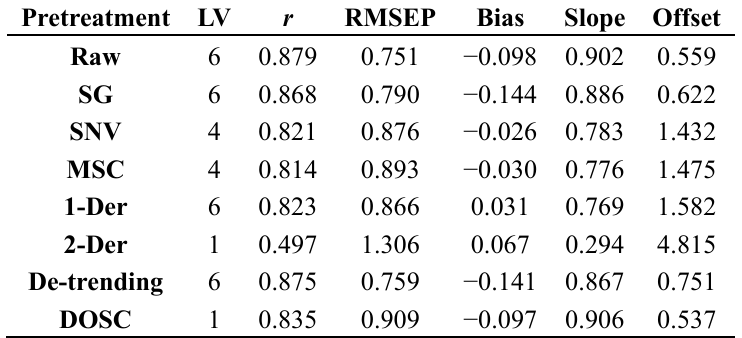
Table 2. The prediction results of TAA in validation set by the PLS models with